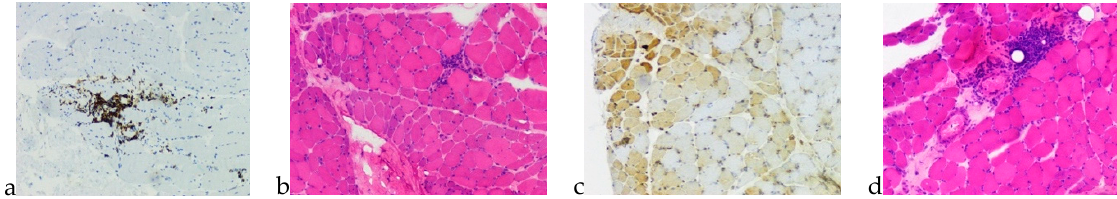
Figure 2. Deltoid muscle biopsy showed ( b ) fiber size variability with perifascicular atrophy, fiber necrosis and regeneration, ( a , d ) perimysial inflammatory infiltrates and ( c ) sarcolemmal expression of MxA (Myxovirus Resistance Protein).